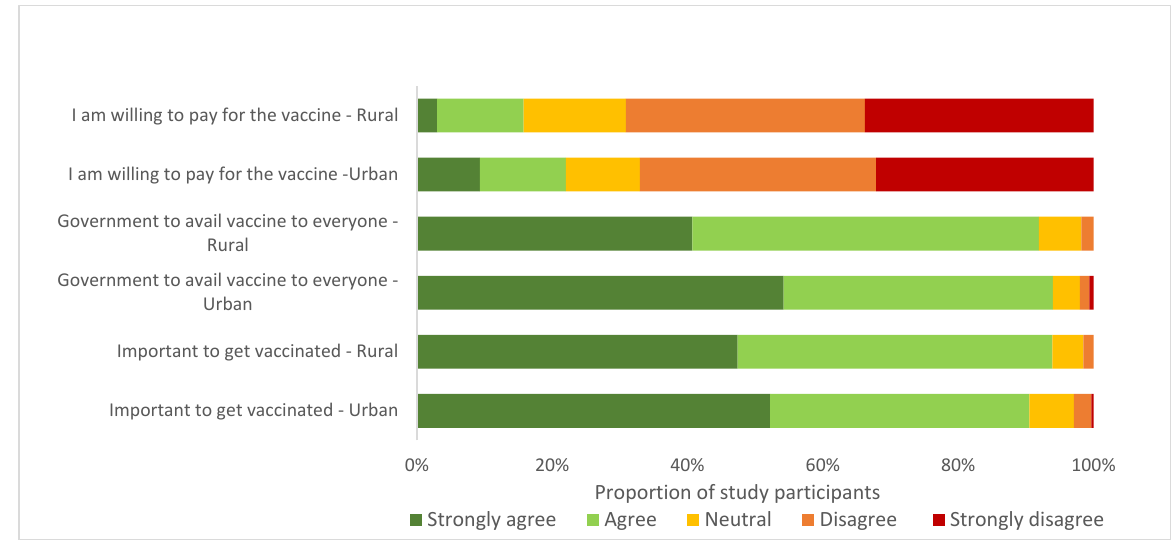
Figure 3. Sources of COVID-19 vaccine information (left panel) and the most trusted sources of COVID-19 vaccine information (right panel) among the urban and rural study participants. Over 90% of the participants (90.5% urban, 93.9% rural) agreed that vaccines were necessary, and that the government should make them available for everyone eligible (Figure 4).